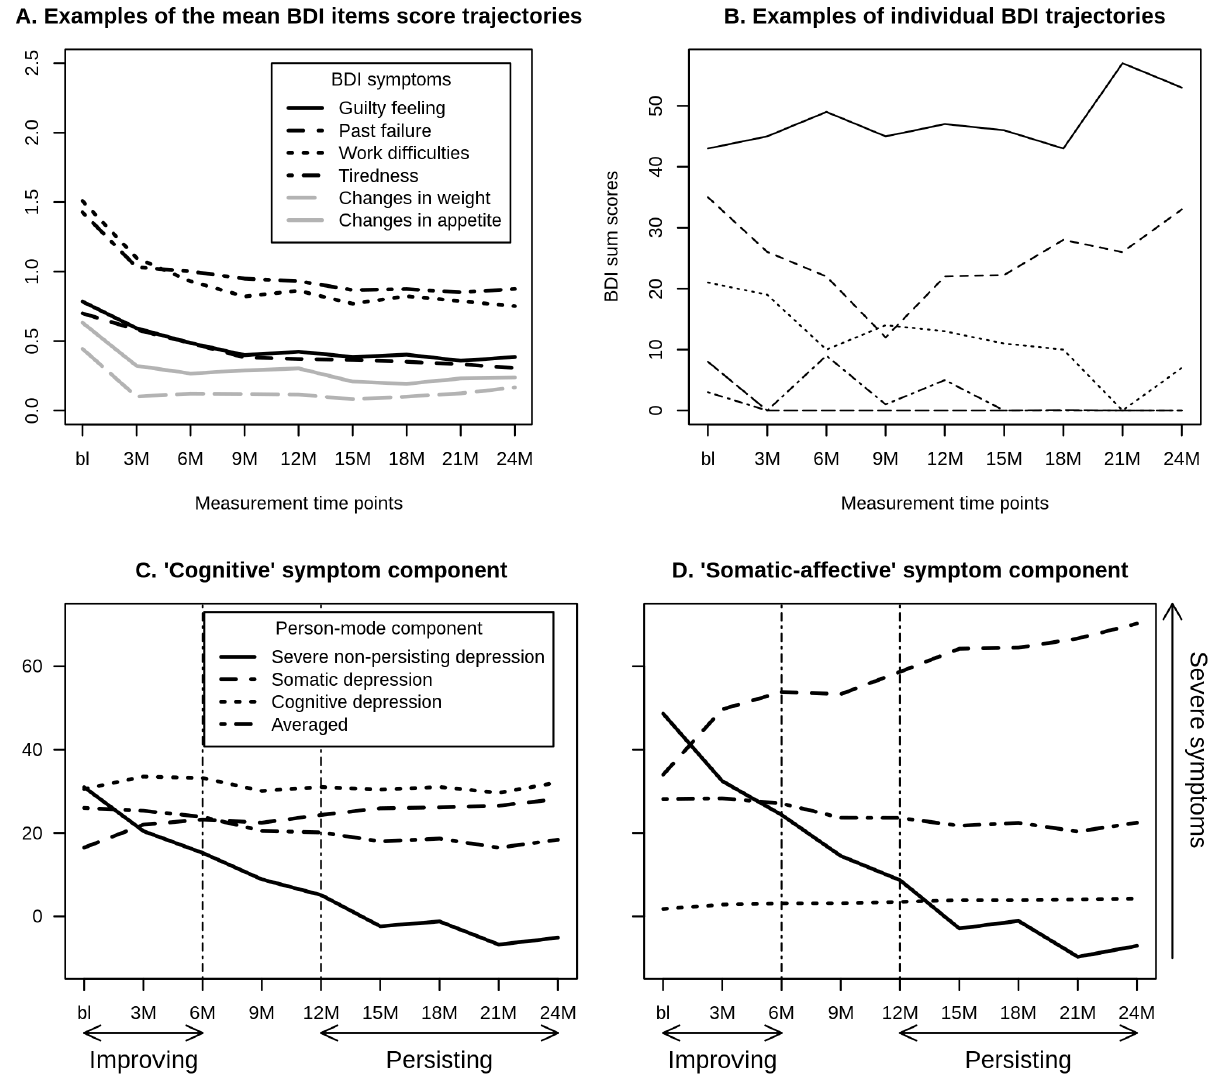
Fig 1. A. Examples of the mean BDI item score trajectories ( ‘ general trend ’ ), B. Examples of five patients ’ individual BDI trajectories, C. Cognitive symptom-component plot around the general trend and D. Somatic-affective symptom-component plot around the general trend for the three person-mode components. The two vertical lines in panels 3 and 4 indicate the divisions between the two time-components (improving and persisting).